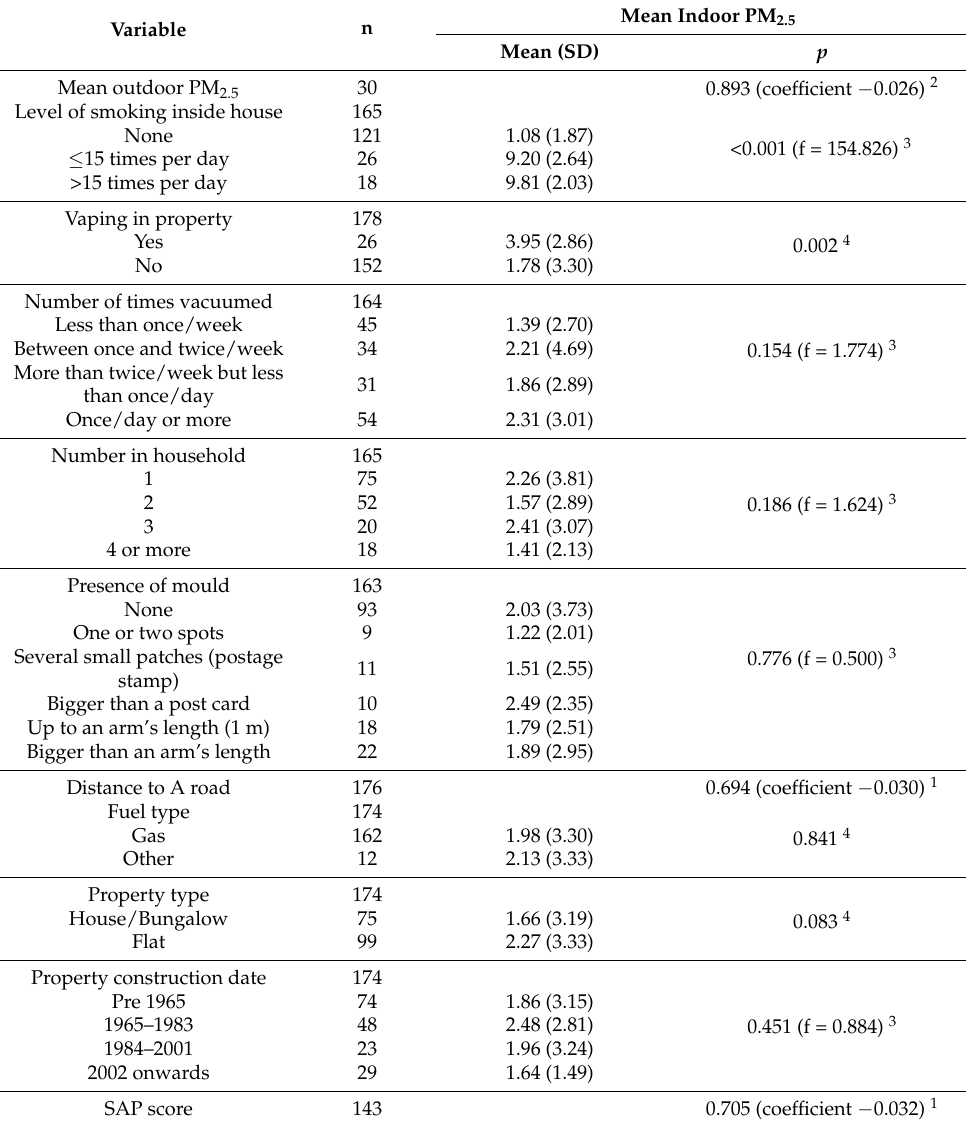
Table 3. Results of statistical tests of association between variables and mean indoor PM 2.5